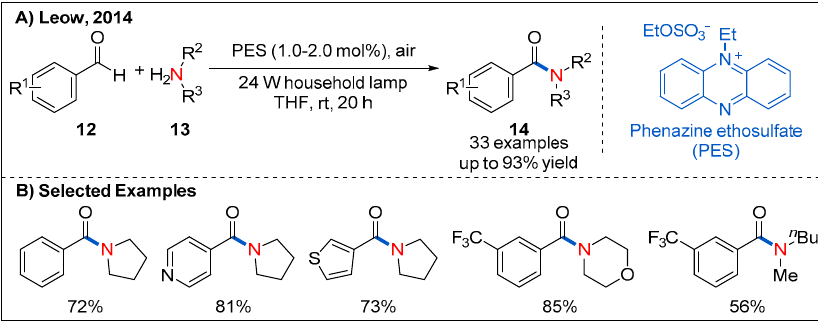
Figure 7. Oxidative amidation and transamidation between aldehydes and amines.